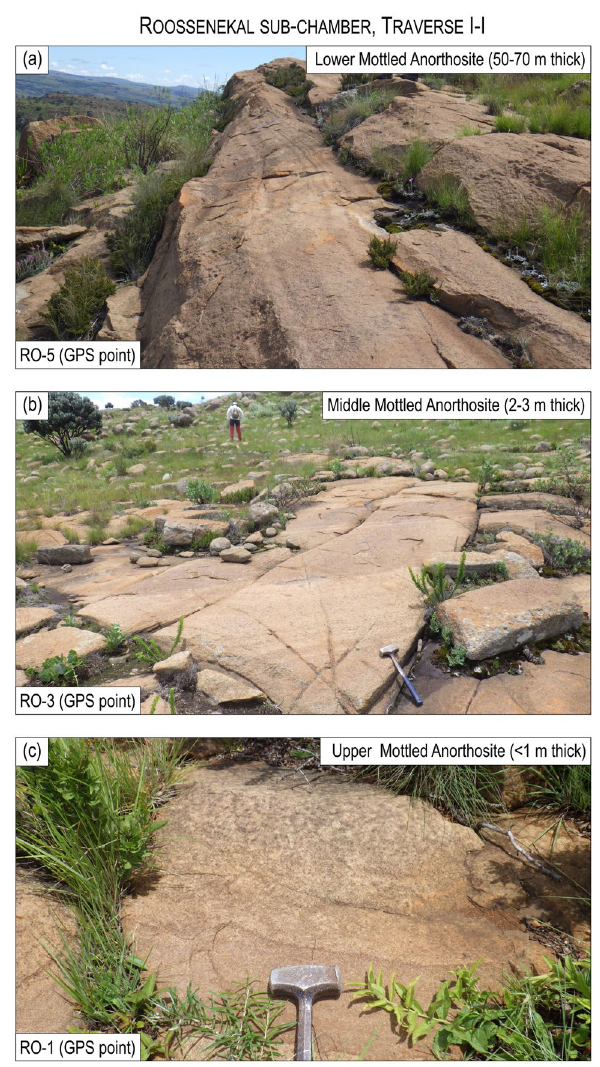
Figure 3. Photos of field outcrops of the three Anorthosite Markers along the traverse I-I of the Roossenekal sub-chamber of the southeastern part of the Bushveld Complex. All photos were taken by Sofya Chistyakova or Rais